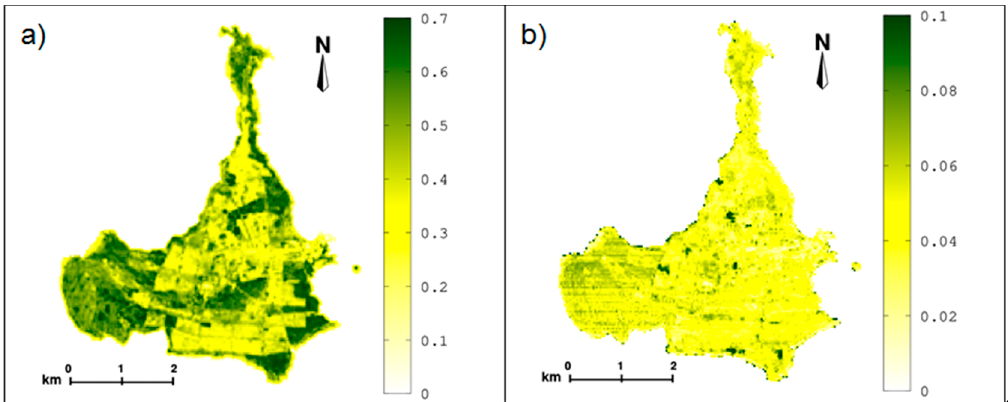
Figure 3. Surface reflectance (SR) normalized difference vegetation index (NDVI) Operational Land Imager (OLI) images for the year 2015. The ( a ) mean ( μ ) and ( b ) standard deviation ( σ ) values of the SR NDVI images were calculated from 06/06/2015 to 20/09/2015 (day of year (DoY): 157, 164, 173, 180, 189, 205, 212, 221, 228, 237, 244, and 253).